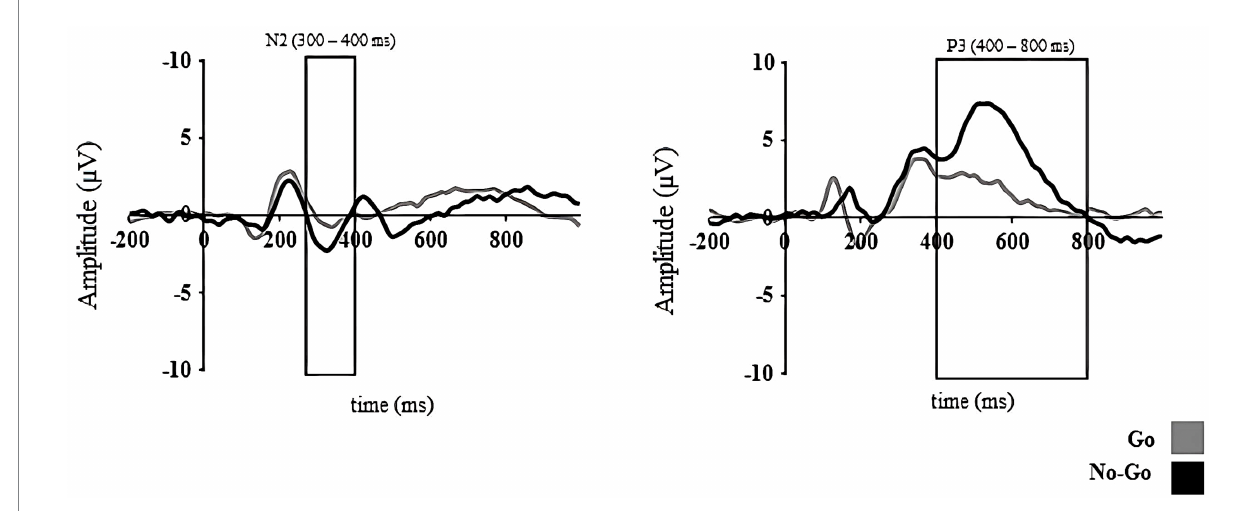
FIGURE 2 N2 and P3 ERP components linked to the target processing in the Go/No-go task. Average ERPs of a set of electrodes around FCz and Pz are shown for N2 and P3 components, respectively.